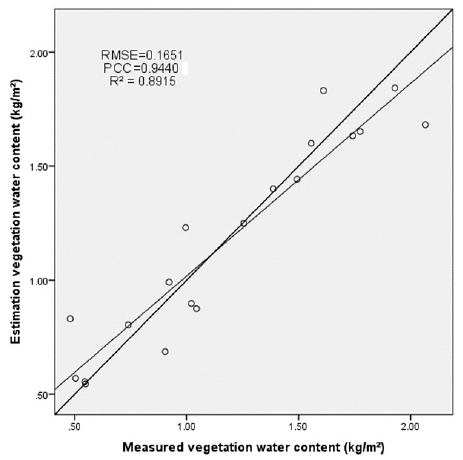
Figure 6. Scatter plot between the measured and estimated vegetation water content values using the new empirical model based on 19 sample datasets. The 1:1 line is included in the plot.